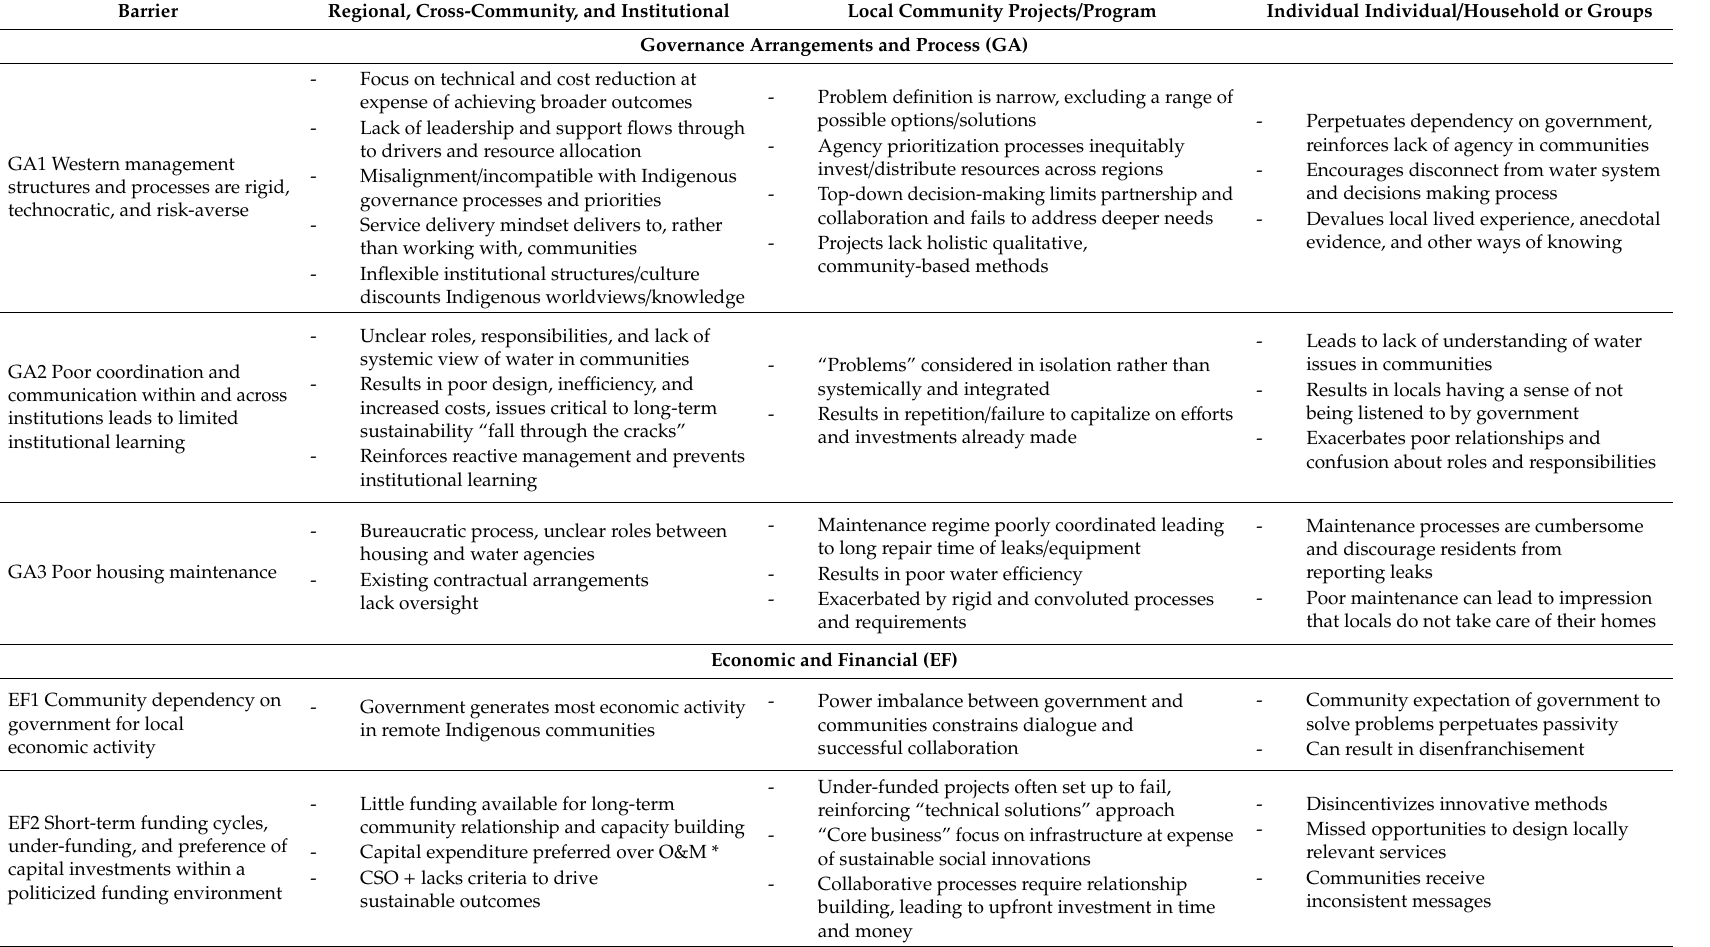
Table A3. Barriers experienced at regional, local, and individual